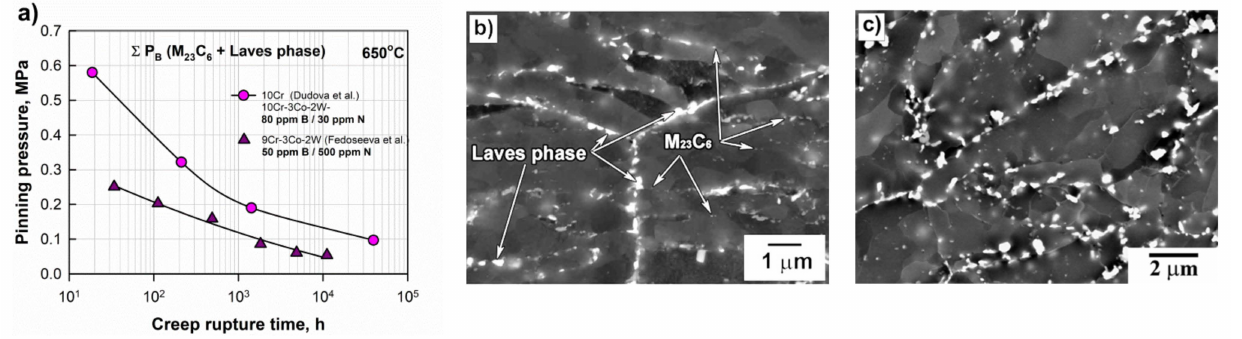
Figure 26. Change in the pinning pressure from M 23 C 6 carbides and Laves phase particles on the grain and lath boundaries of the 10Cr steel with increased B and decreased N contents and the 9Cr-3Co-2W steel with conventional B and N contents during creep tests at 650 ◦ C and different applied stresses 180–120 MPa ( a ). Data from [8,21]. Microstructure of the steels after creep tests at 650